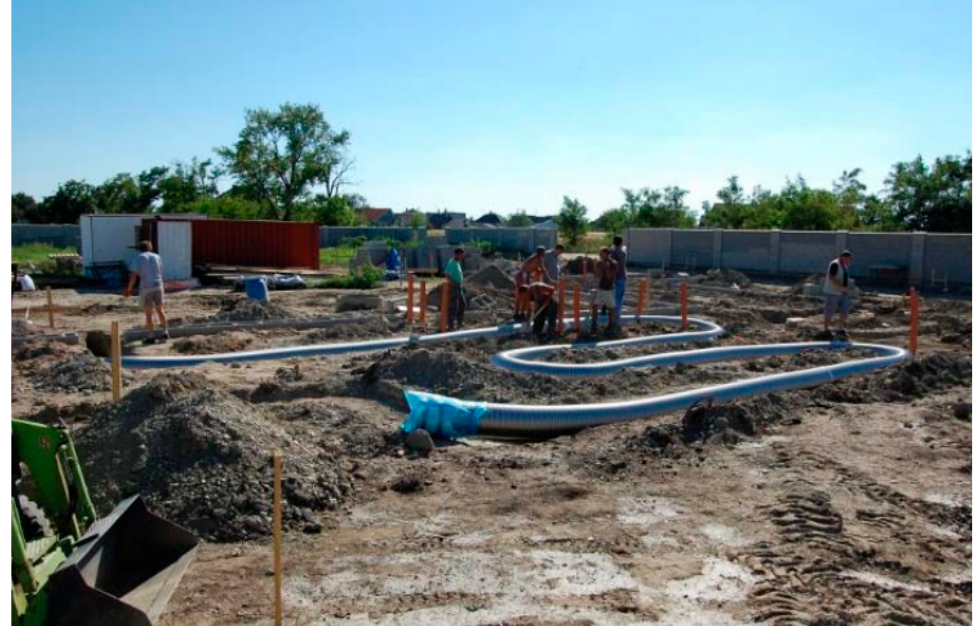
Figure 6. Heat recovery ventilation pipe in a pipe located both below the building and outside the building [1,2].